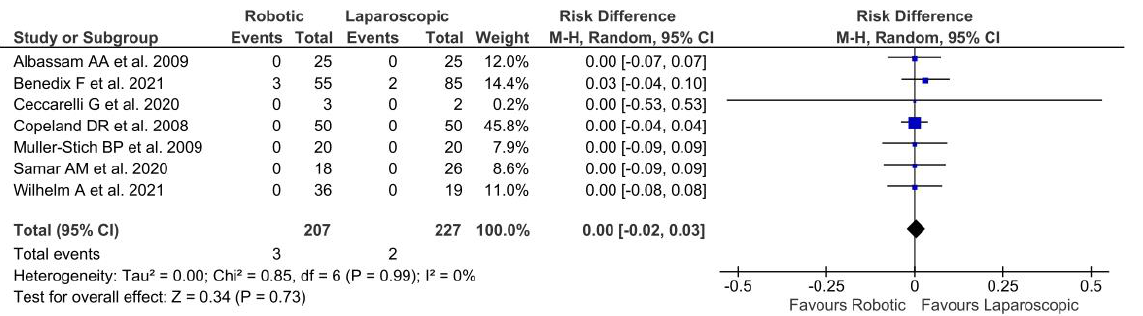
Figure 4. Forest plot of laparoscopic vs. robotic 30day readmission rates [22,23,25,26,33,35,37].